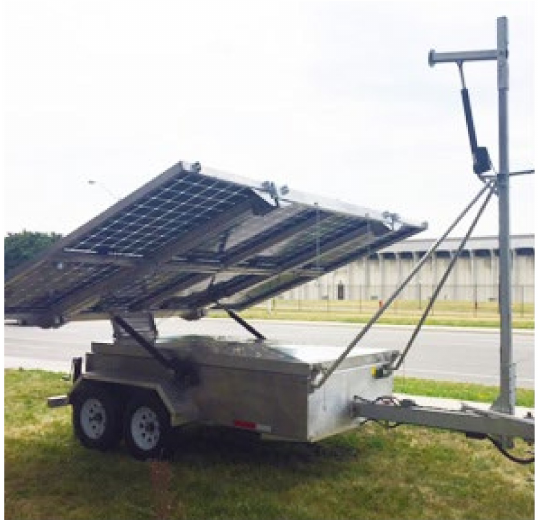
Figure 4. Mobile solar-wind power plant by MOBISMART (source, https://mobismart.ca/mobile- hybrid-wind-solar-system (accessed on 12 November